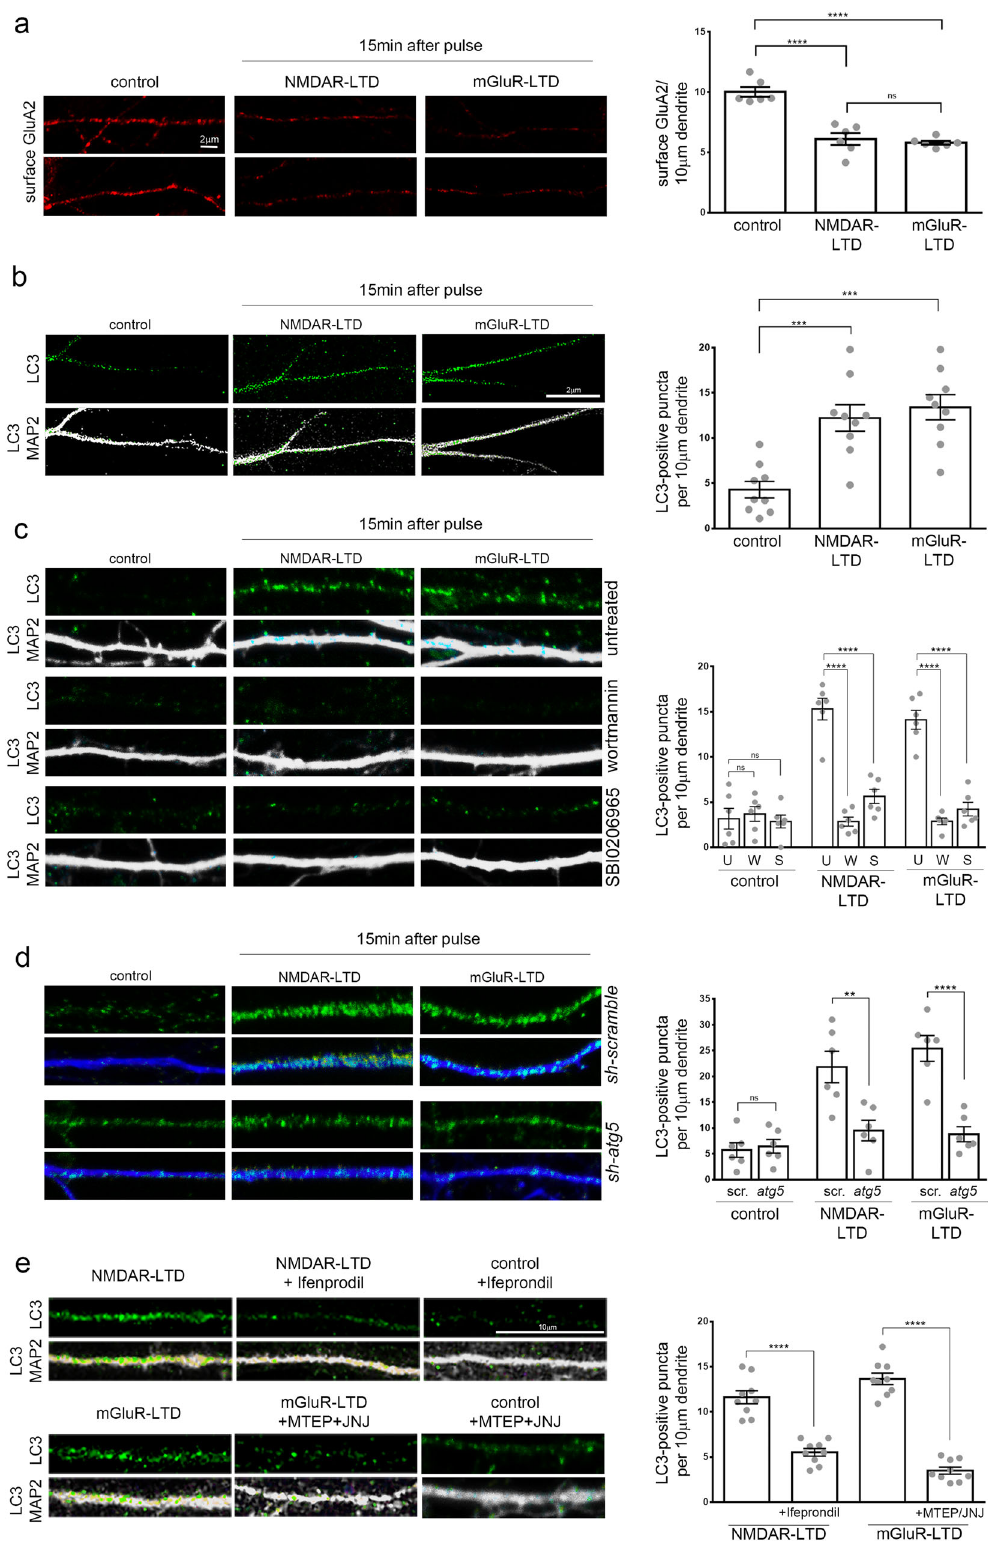
Autophagic vesicles are locally generated in postsynaptic den- drites upon LTD . Lipidated LC3 associates with autophagic membranes during phagophore biogenesis and is maintained in the mature autophagic vesicles, both in their inner and outer membranes 41 . The rapid emergence of dendritic LC3-positive puncta within 15 min after LTD, invites the speculation that